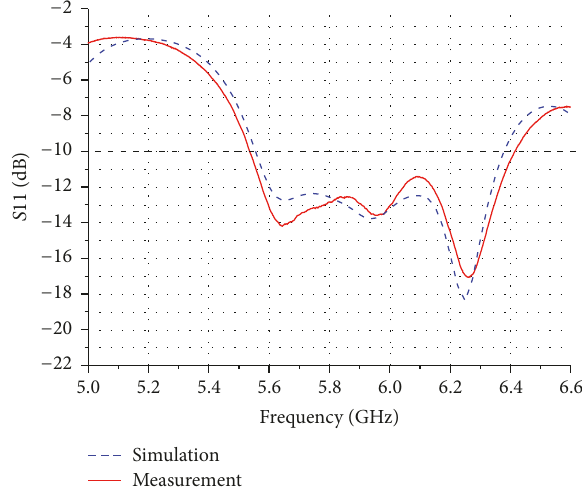
Figure 10: Measured and simulated |𝑆11| of the 1 × 2 linear